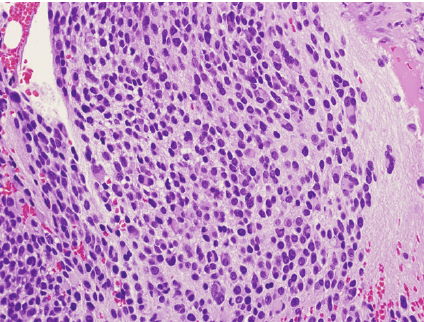
Figure 2: The H&E stained section of the bone marrow biopsy demonstrates extensive involvement by neuroblastoma with a back- ground of neuropil. Magnification is 400x.